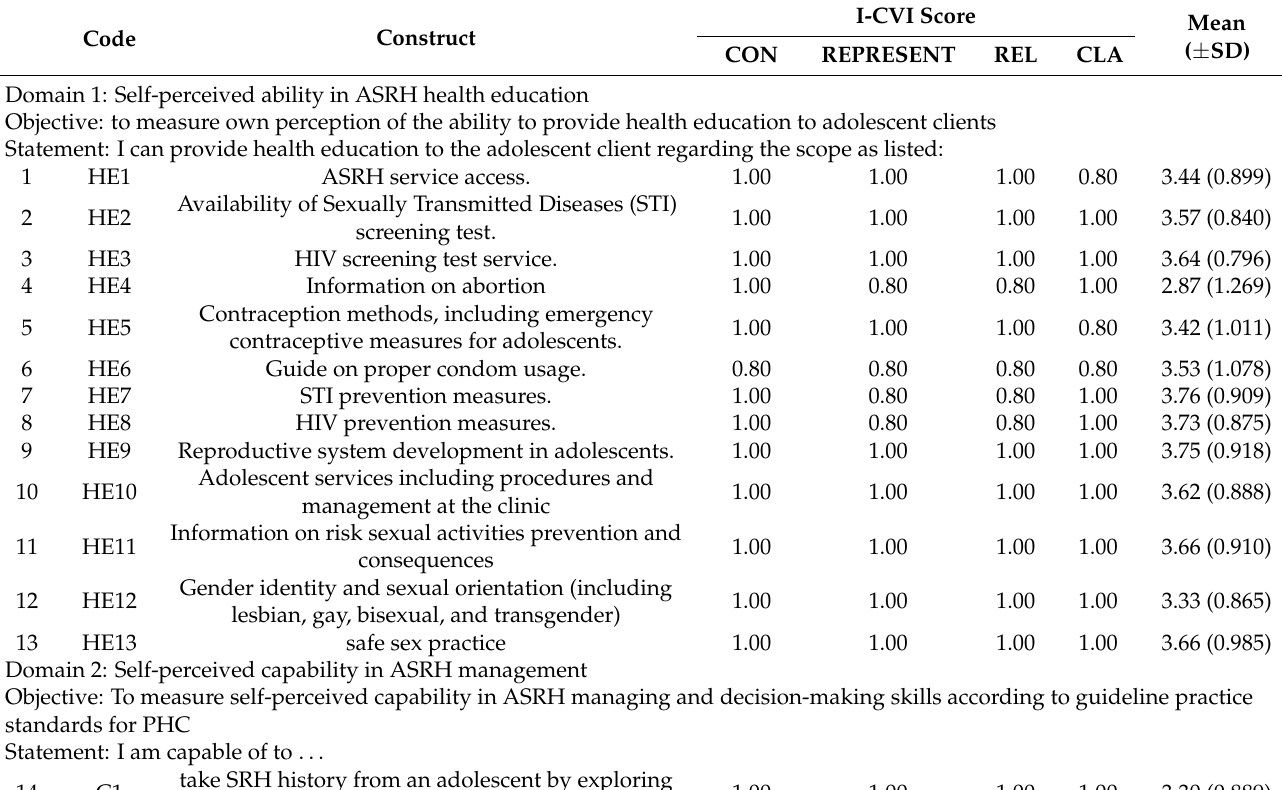
Table 1. CVI assessment for tool items based on consistency (CON), representativeness (REPRESENT), relevance (REL), and clarity (CLA), by